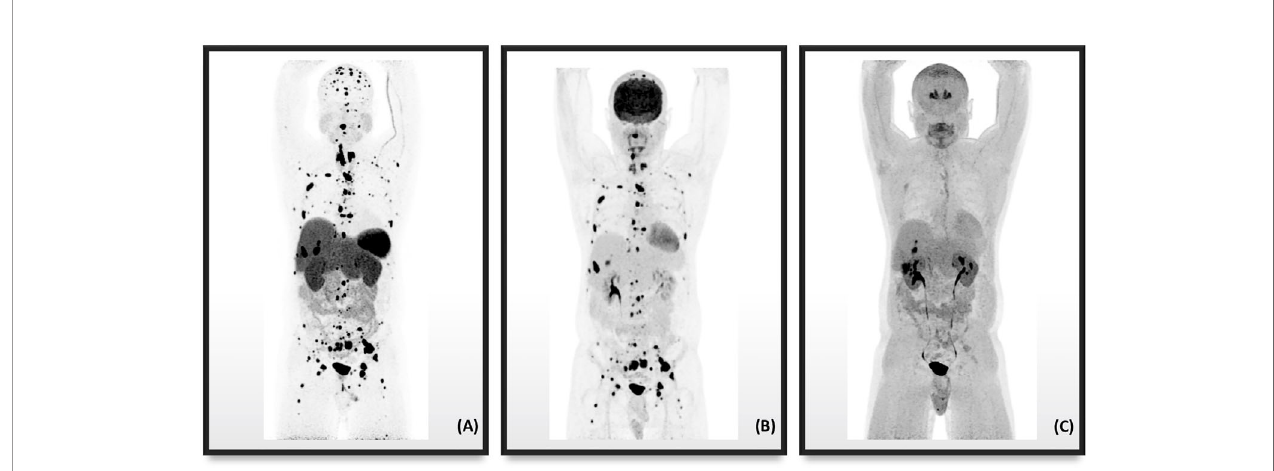
FIGURE 3 | PET/CT radiotracer imaging of a 41-year-old male with metastatic PPGL in the setting of SDHB mutation. (A) 68 Ga-DOTATATE displaying more metastatic disease than radiotracers (B) 18 F-FDG and (C) 18